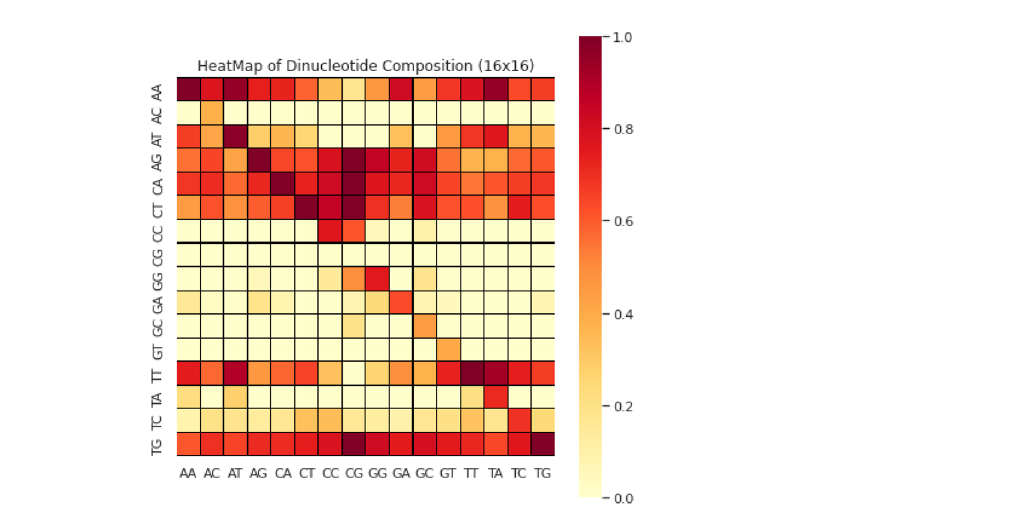
Figure 2. The heatmap of dinucleotide composition based